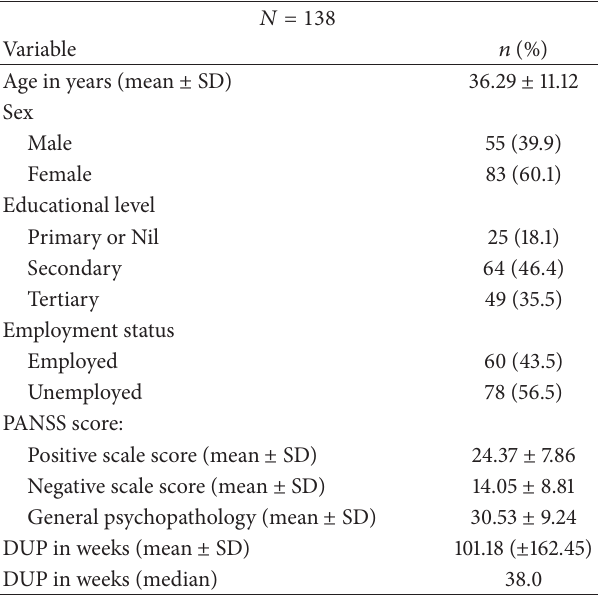
Table 1: Sociodemographic and clinical characteristics of the